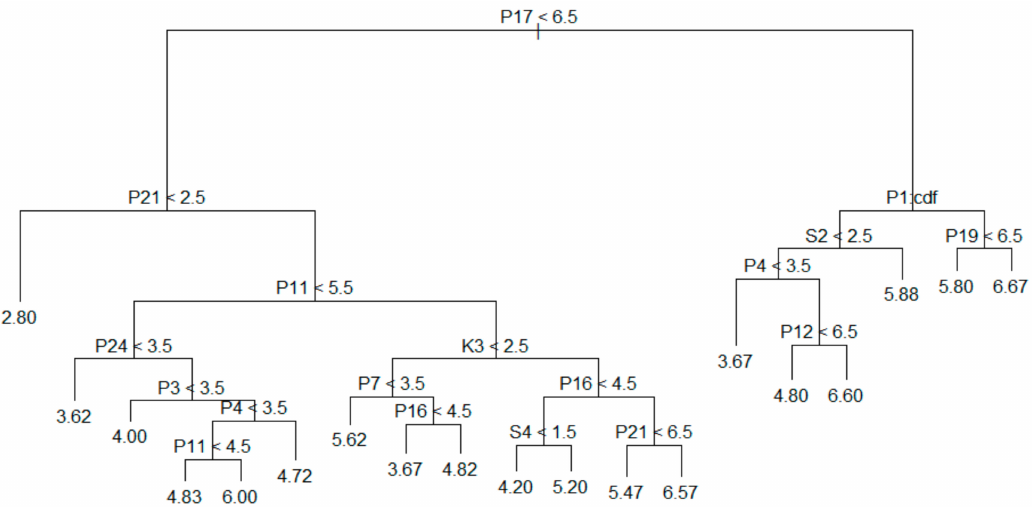
Figure 3. Classification tree of customers loyalty in incentive perspective. Source: authors’